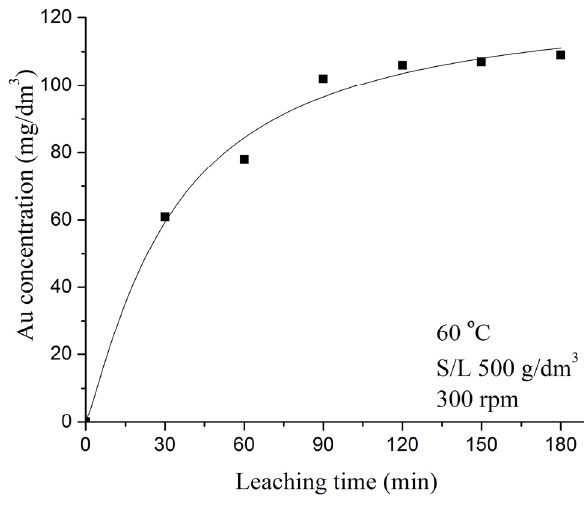
Figure 8. Influence of leaching time on Au leaching efficiency.